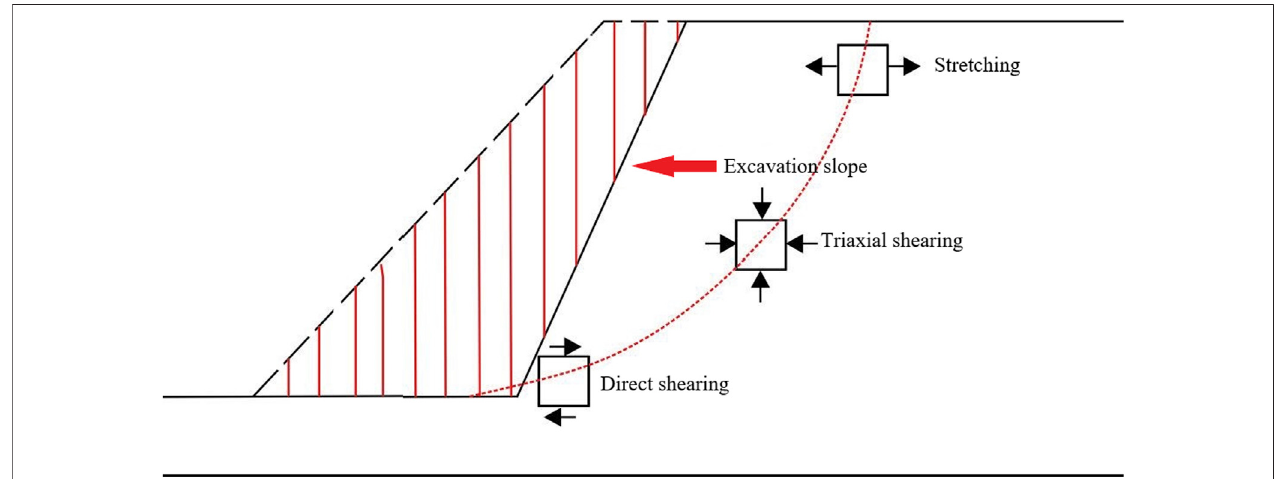
FIGURE 4 | Sketch map of unloading stress paths.